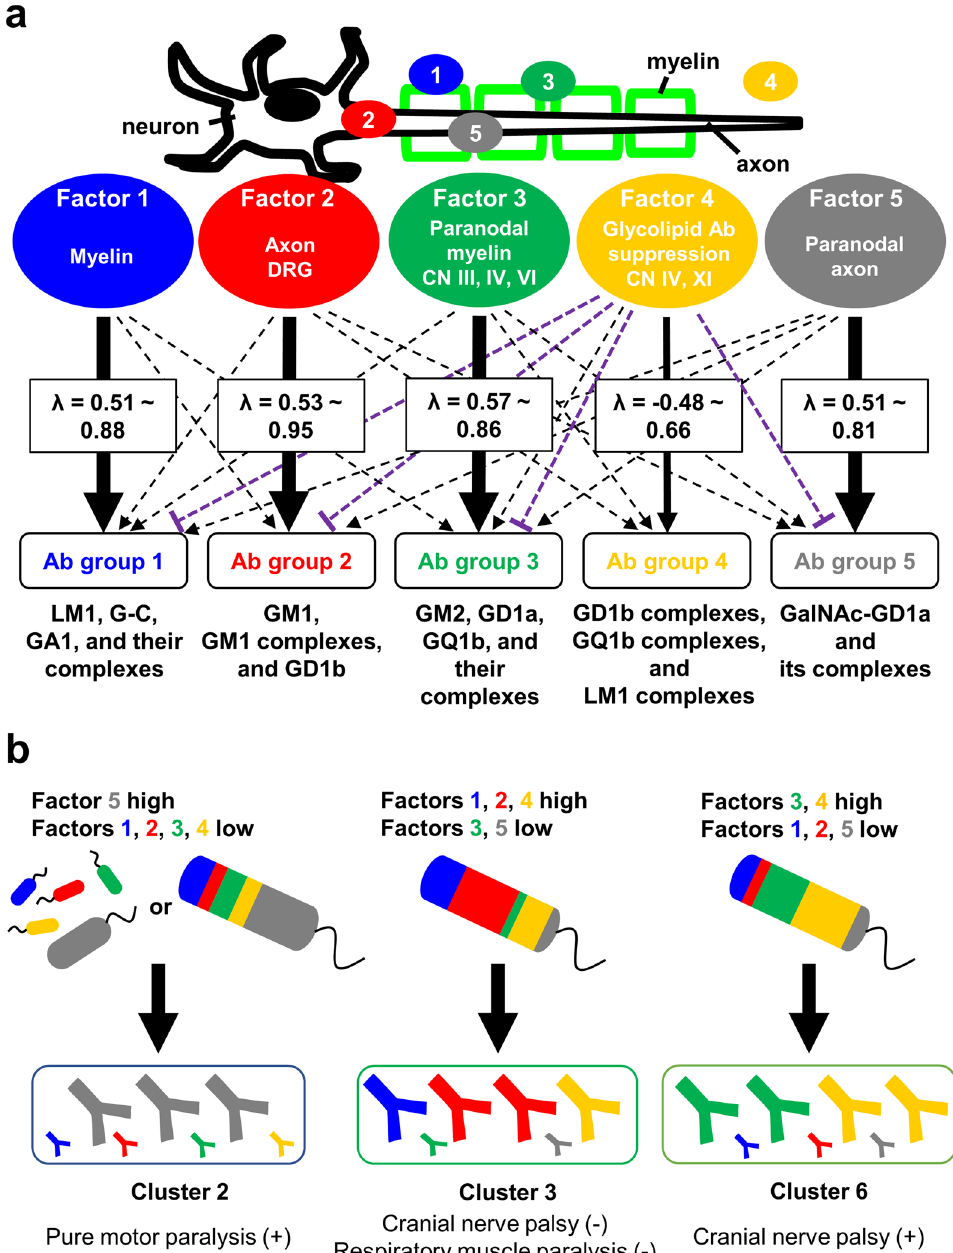
Figure 8. Working models of how each factor associates a set of glycolipid antibodies. ( a ) Based on the factor loadings, each factor was associated with a distinct set of anti-glycolipid antibodies (Ab). Each factor, except for Factor 4, was associated with distinct glycolipid antigens in the peripheral nervous system. Factor 1 was associated strongly with antibodies against LM1, G-C, GA1, and their complexes, Factor 1 can be myelin antigens. Factor 2 contains antibodies against GM1 and GM1 complexes, which are components of the axonal membrane, and GD1b, whose antibody can bind the dorsal root ganglia (DRG). Factor 3 contains the antibodies against GM2, GD1a, and GQ1b, which are paranodal myelin antigens of cranial nerves (CN) III, IV, and VI. Factor 4, which was associated with involvement of CN IV and XI, may be a latent factor that suppresses the production of a group of anti-glycolipid antibodies. Factor 5 contains the antibodies against GalNAc-GD1a and its complexes, which are components of the paranodal axonal membrane. ( b ) GBS patients could be classified into six clusters based on k -means clustering of our EFA results. Each cluster has a unique pattern of five factors (Factor 1 to Factor 5). For example, sera of patients in Cluster 2 had high factor scores in Factor 5. Sera of patients in Cluster 3 had high factor scores in Factors 1, 2, and 4. Sera of patients in Cluster 6 had high factor scores in Factors 3 and 4. In theory, the difference in the factor score patterns among six clusters can be due to simultaneous multiple exposures by several factors, each of which have a different antigenicity level (upper left of Cluster 2 figure), or an infection with one microbe containing multiple antigens with different antigenicities (upper right of Cluster 2 figure, and Cluster 3 and Cluster 6 figures), leading to the production of unique sets of glycolipid antibodies or causing specific clinical